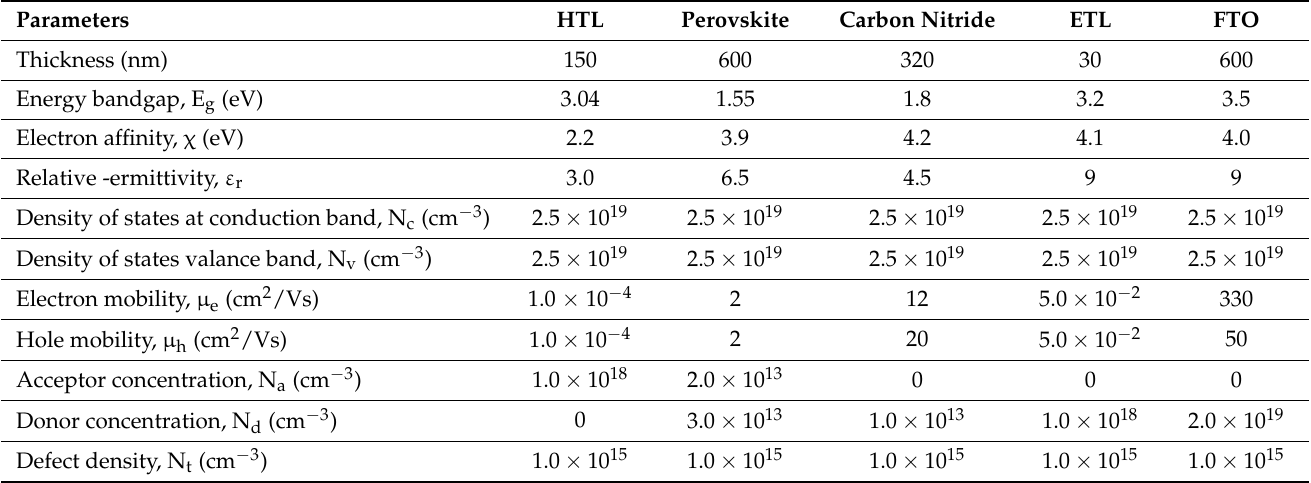
Table A1. Input layer parameters for numerical modeling of double-absorber-layer solar cell. The material parameters were adopted from the literature [16,40], as well as being